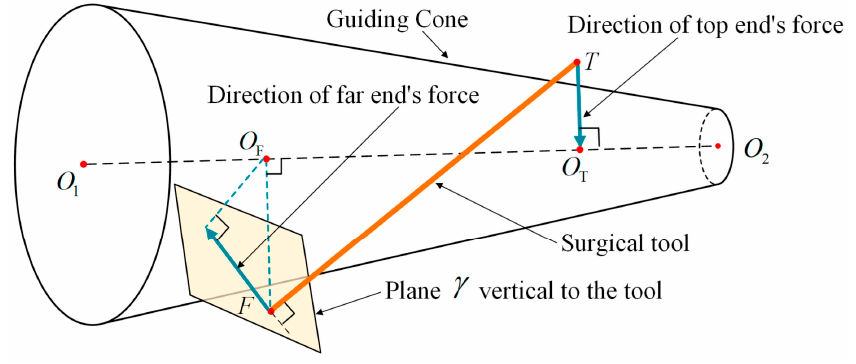
Figure 9. Definition of the direction of the repulsive forces. Based on the vector projection matrix, the direction of the repulsive force on the two endpoints can be obtained as Equations (10) and